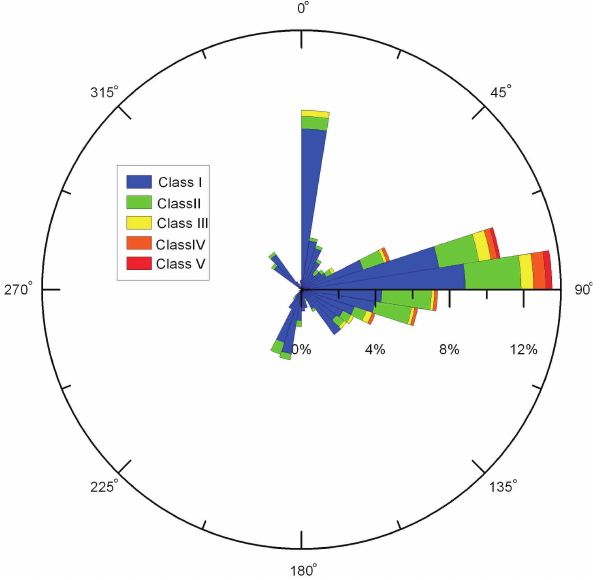
Fig. 6. Directional distribution of storms in the Catalan coast during the period 1988/2008.